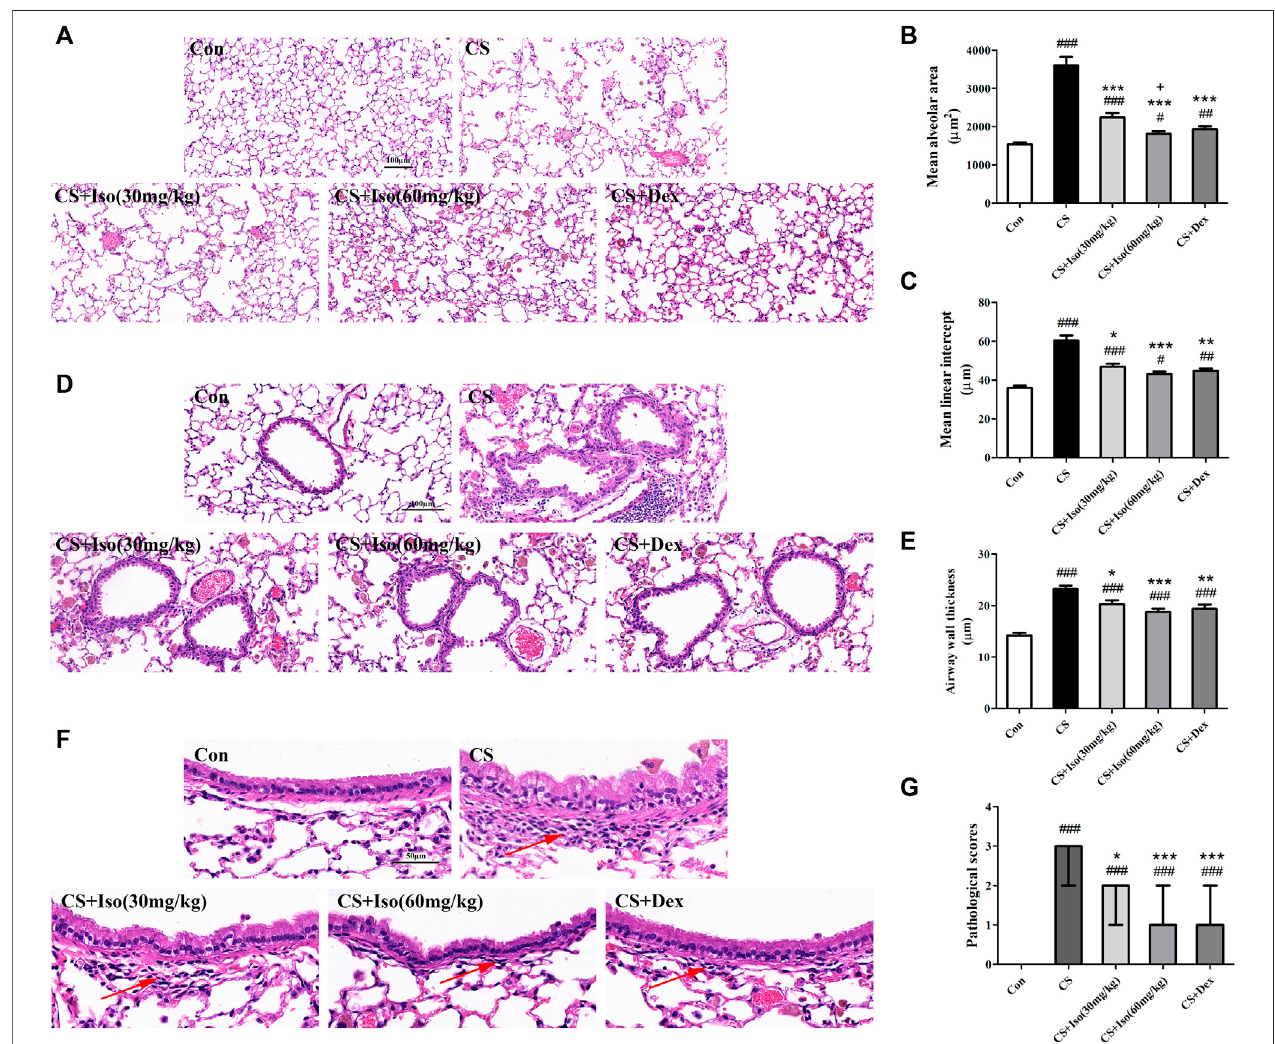
FIGURE 4 | Iso reduces emphysema and in fi ltration of in fl ammatory cells in the lungs of CS-induced COPD mice. Lung tissues were subjected to H&E staining. Representative histopathological sections of mouse lungs showed various degrees of (A) distensible alveolar spaces (scale bar 100 μ m), (D) incrassate bronchial walls (scale bar 100 μ m) and (F) in fi ltrative in fl ammatory cells (arrow) (scale bar 50 μ m). These lesions were quanti fi ed using different indicators for statistical analysis, as seen by the (B) mean alveolar area and (C) mean linear intercept, which were quantitative analysis of the severity of emphysema ( n = 5 mice per group). Moreover, quantitativeanalysisofthedegreeofin fl ammation inlungswasdetermined by (E) theairwaywallthicknessand (G) pathologicalscores( n =5miceper group). Datawas shownasmean(±SD) (B,C,E) andmedian(±IQR) (G) .Totestforgroupdifferencsesone-wayANOVA (B,C,E) andKurskal-Wallis (G) wereapplied. # p < 0.05, ## p < 0.01, ### p < 0.001 vs. control group, * p < 0.05, ** p < 0.01, *** p < 0.001 vs. CS group and + p < 0.05 vs. CS + Iso 30 mg/kg group.